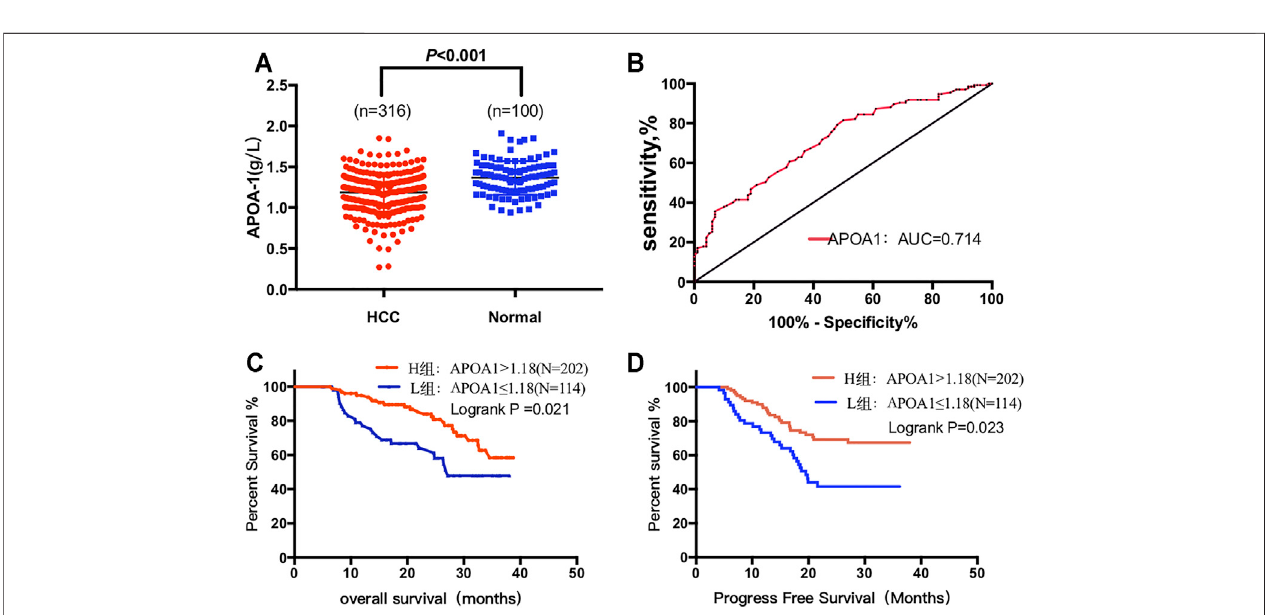
FIGURE7| CirculatingserumAPOA-1proteininpatientswithHCC. (A) serumAPOA-1proteinishigherinhealthycontrolsthaninHCC; (B) AUCforAPOA-1.High expression APOA-1 is associated with better (C) OS and (D) PFS in 316 patients with HCC.